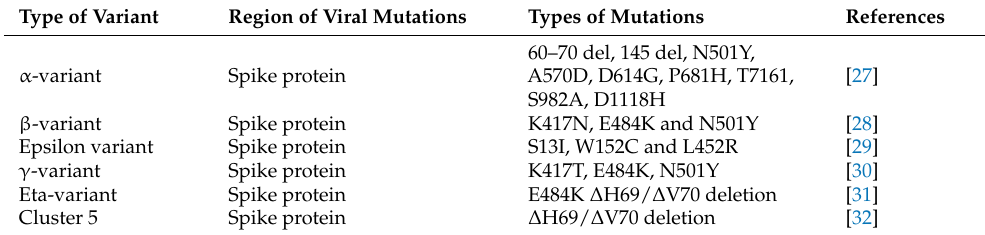
Table 1. Regions of mutations in the different SARS-CoV-2